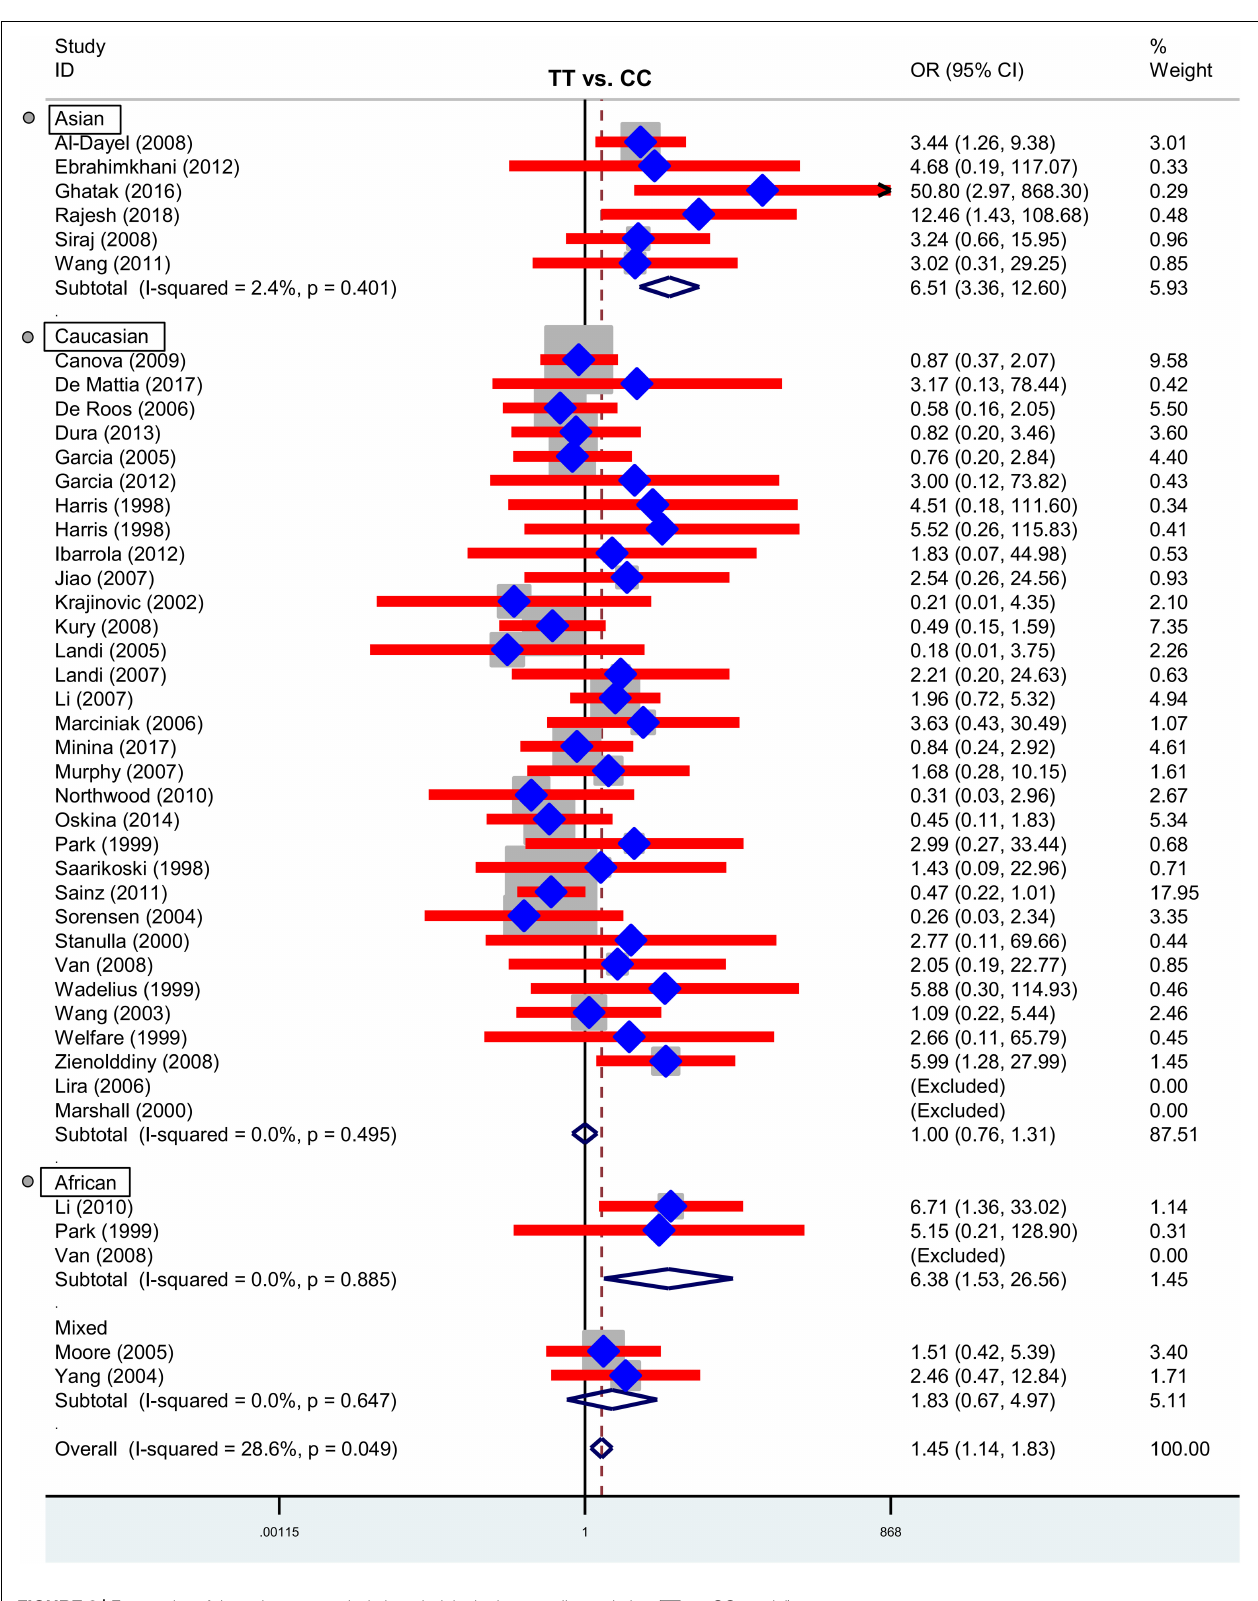
Frontiers in Physiology |